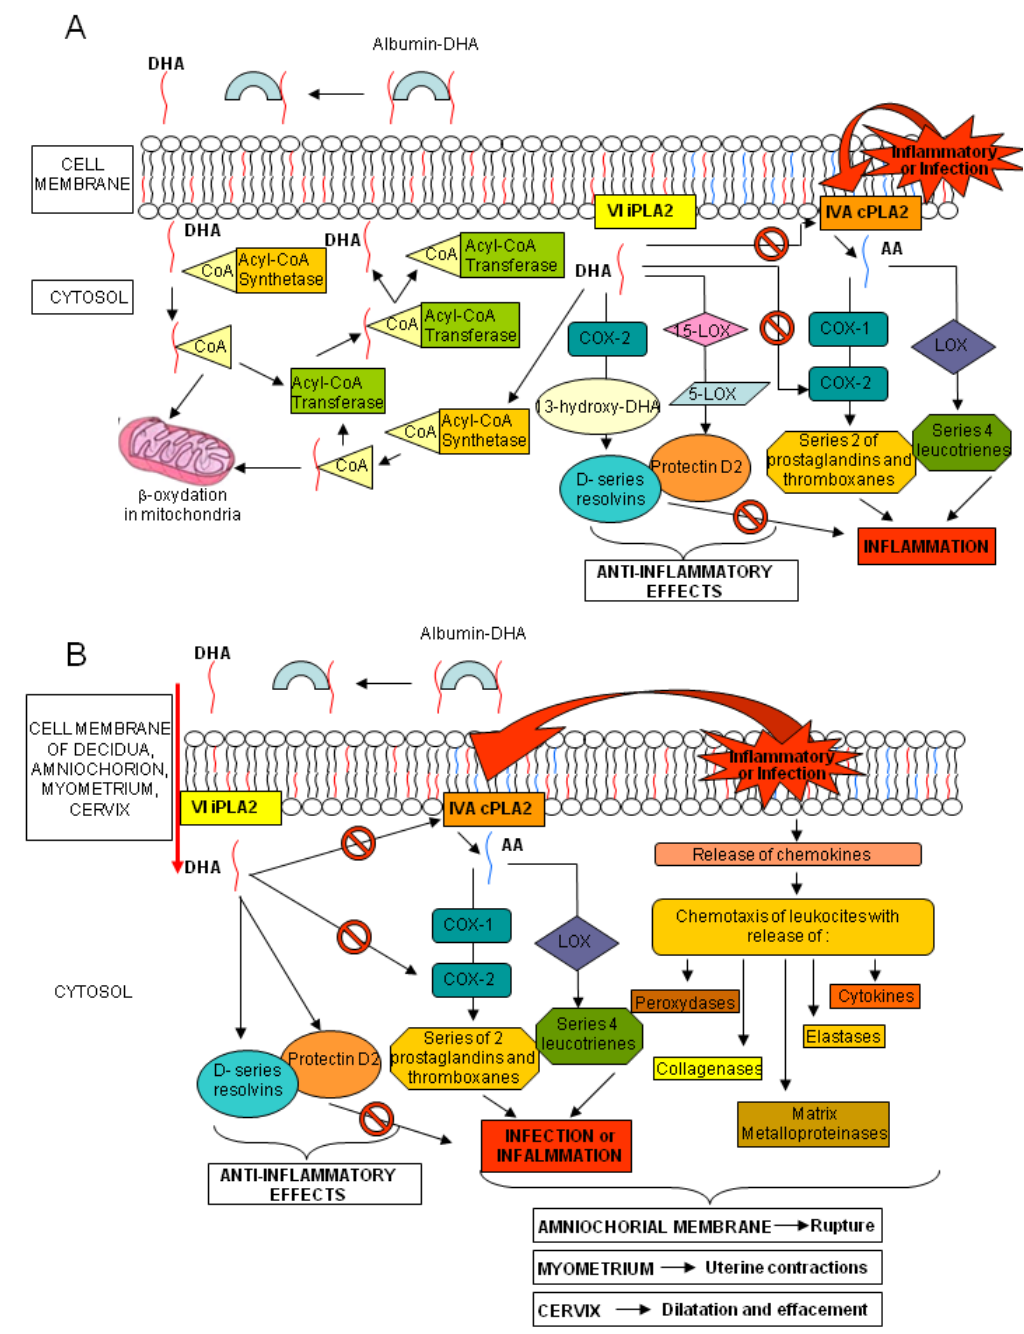
Figure 1. Metabolism of DHA. Panel ( A ) Interactions in DHA and AA metabolic cascades; and Panel ( B ) DHA, resolvin and protectin putative effects on labor and amniochorial membrane rupture